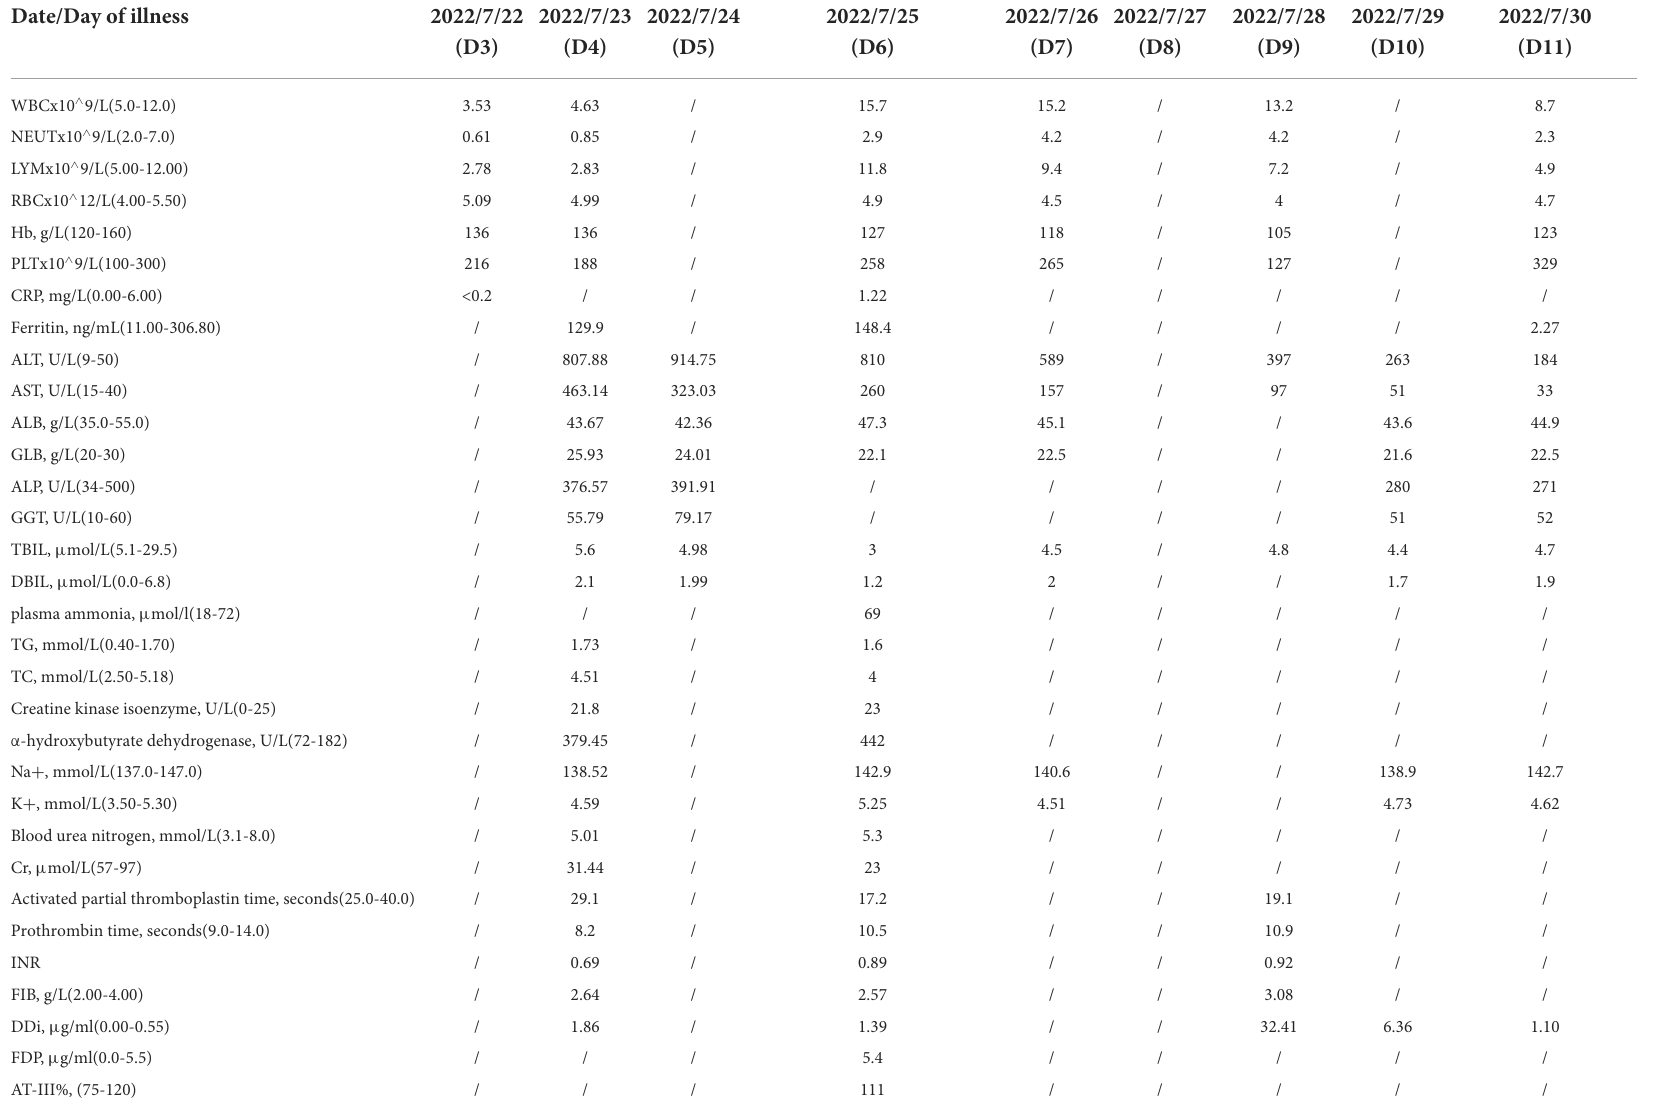
TABLE 1 The findings of laboratory